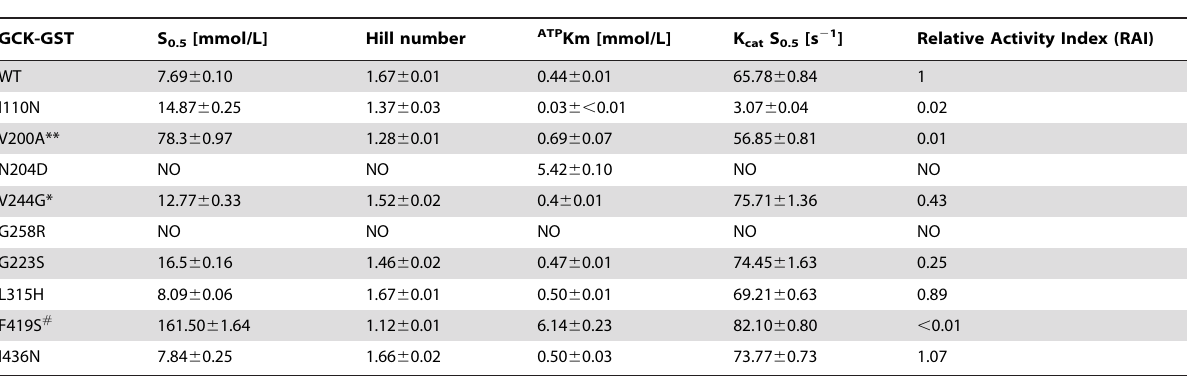
further 72 individuals with GCK mutations. With 337,187 patients with diabetes in Slovakia (Slovak National Health Information Center, 2010), and GCK-MODY confirmed in 108 individuals, this represents 0.03% of all diabetic patients. Recalculated to the number of inhabitants in Slovakia (5.4M, Slovak National Health Table 3. Kinetic characterisation of GCK-MODY